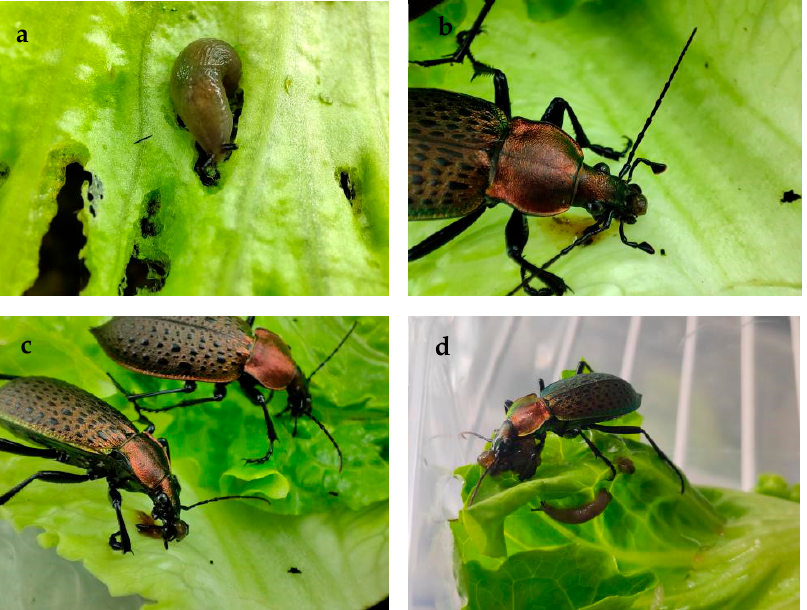
Figure A1. A. agrestis damaging lettuce ( a ); female adult of C. elysii feeding on A. agrestis ( b ); male adult of C. elysii attacking A. agrestis ( c – d ).